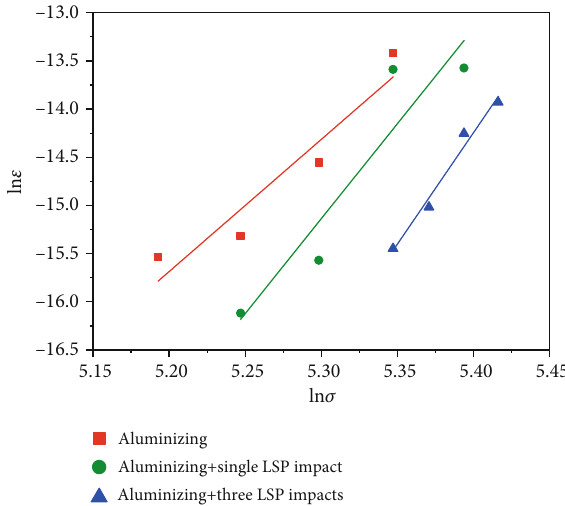
Figure 6: Creep rupture strength of 321 stainless steel treated with di ff erent surface modi fi cation processes examined at 620 ° C. Figure 8: Double logarithmic relationship of creep rate and stress for aluminized specimens at di ff erent surface modi fi cation processes.